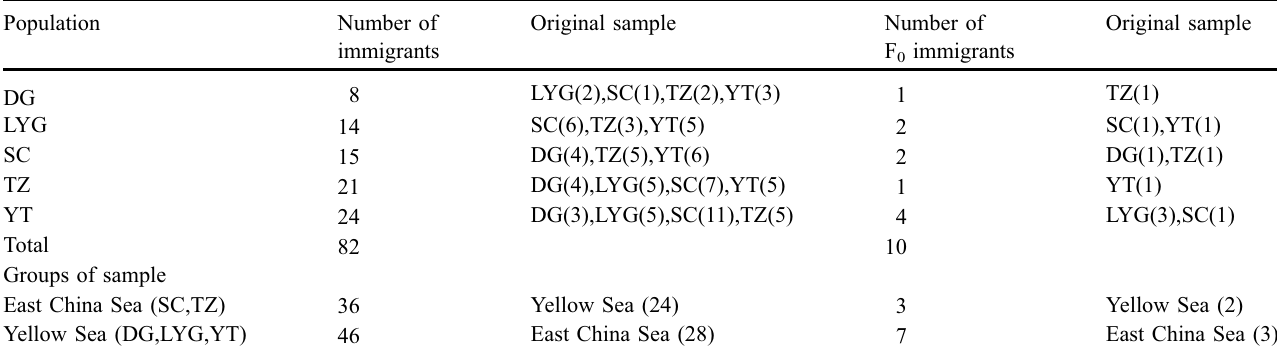
Table 3. Number of immigrants assigned to a given population performed with